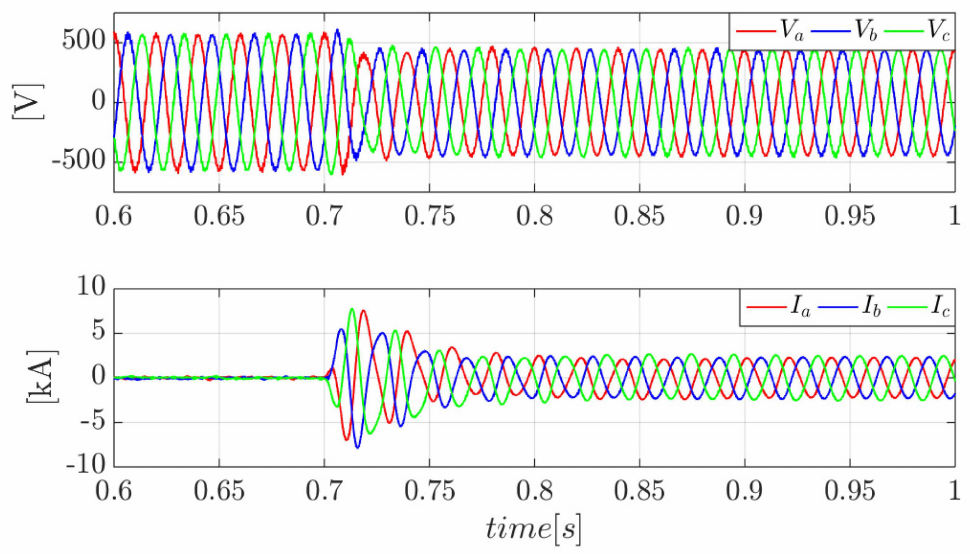
Figure 15. GFM converter instantaneous voltage and currents during a balanced fault with 0.22 p.u.